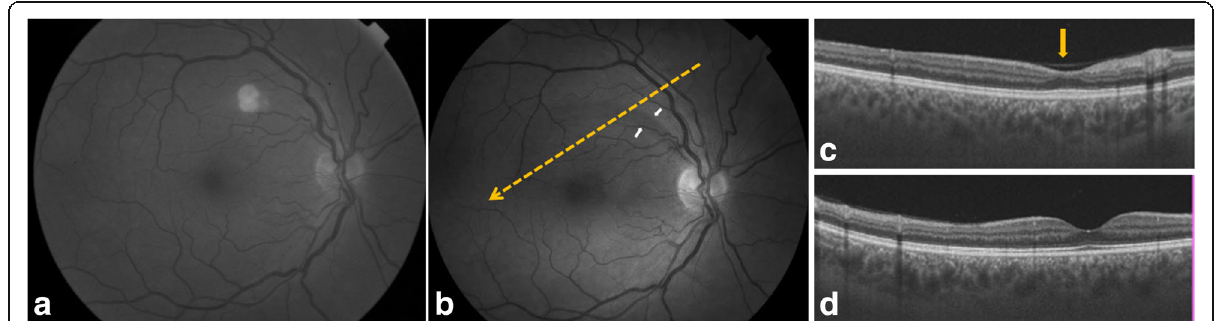
Fig. 5 A 43-year-old patient complained of floaters, OU. Red-free fundus photograph of the right eye shows a mid-sized white retinal infiltrate in the posterior pole ( a ). Serology confirmed Mediterranean spotted fever. Red-free fundus photograph, taken 3 months after presentation, shows resolution of the retinal infiltrate with development of a retinal nerve fiber layer defect demarcated by the white arrows ( b ). Spectral-domain OCT image section passing through the clinically visible localized retinal nerve fiber layer defect (yellow dashed arrow in b ) shows an indentation (arrow) corresponding to a thinning of the retinal nerve fiber layer ( c ). Spectral-domain OCT image section passing through the foveola shows normal findings ( d